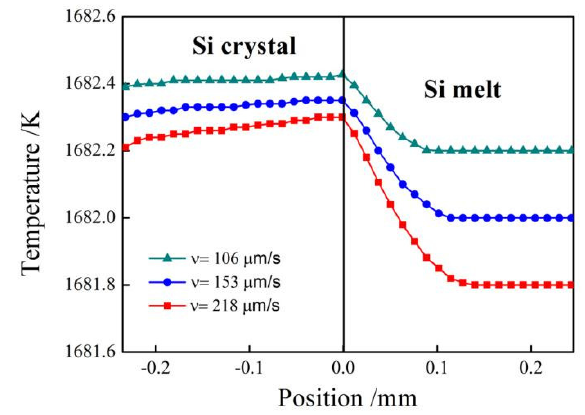
Figure 4. Temperature fields of Si crystal and melt during crystallization for v e = 106 µ m/s, 153 µ m/s , and 218 µ